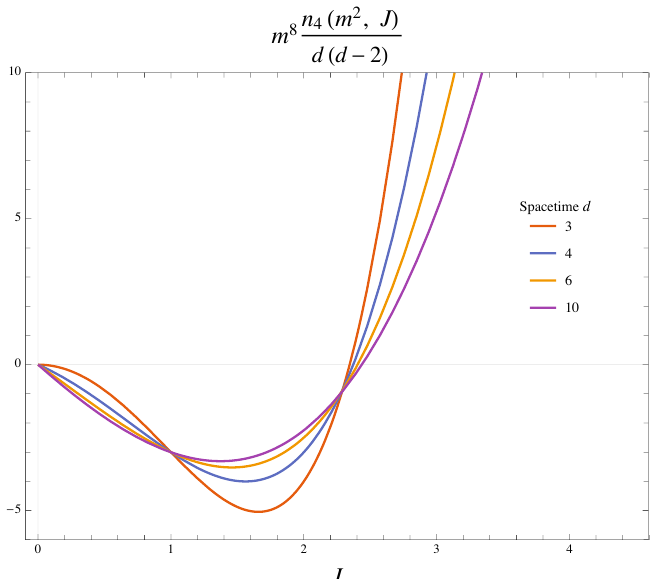
Figure 5. The null constraint m 8 n 4 ( m 2 , J ) , which is a function of only J . It vanishes at J = 0 , is negative at J = 2 , but positive at J = 4 , 6 , . . . , and thus balances spin-two against higher-spin states. The sign change in various space-time dimensions (at J is always situated between 2 < J < 3